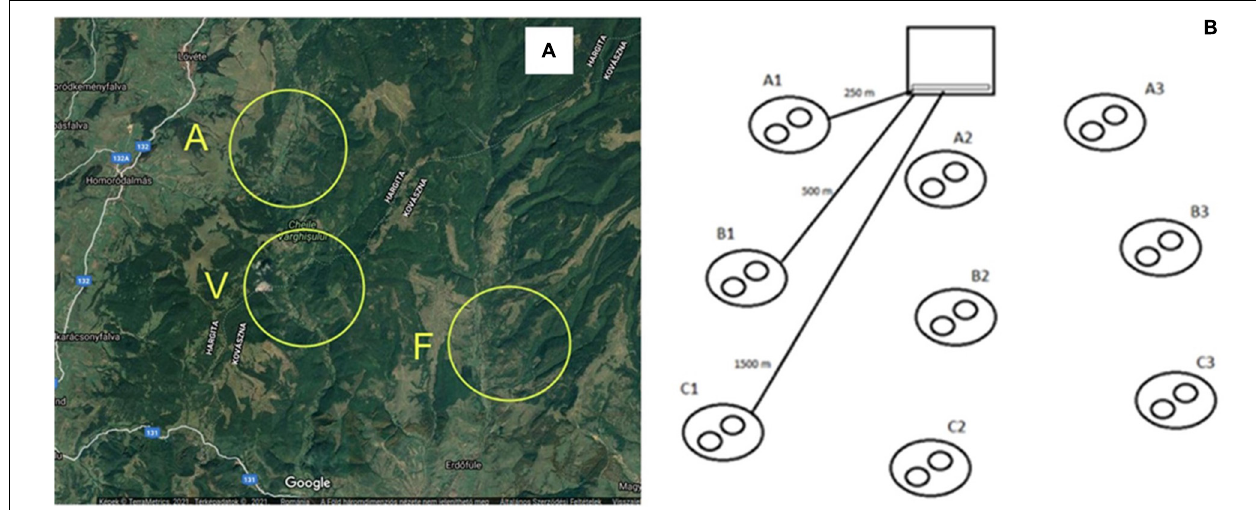
FIGURE 1 | Map of the sampled areas (A) , natural reserve sites A (N:46.2394164, E:25.5322366) and V (N:46.2034539, E:25.5344264), and control area F (N:46.1731241, E:25.6236372), which includes honeybees previously. Sampling model (B) including distances from beehives.